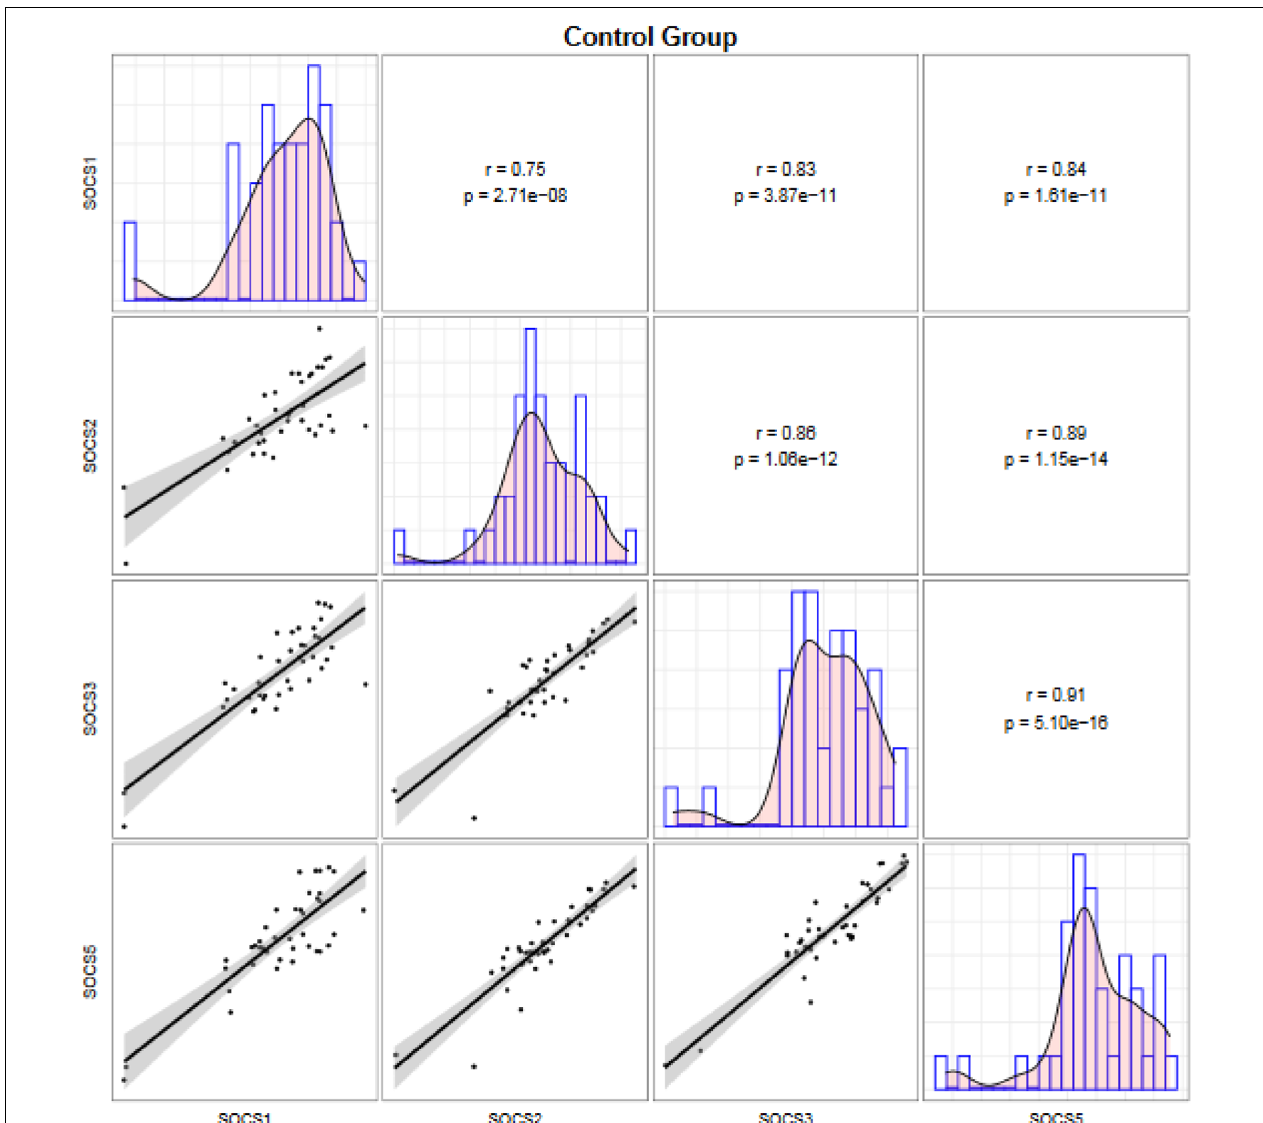
FIGURE 3 | Correlation between transcript levels of the SOCS genes among controls. Distributions of expression data of the SOCS gene are presented on the diagonal. The bivariate scatter plots are shown on the bottom of the diagonal. The upper part of the diagonal shows correlation coefficients (r) and P values.